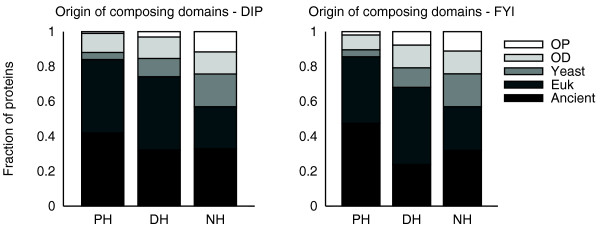
Protein age. The age of a protein is here estimated from the age of its domains. Domains may be found in: eukaryotes and prokaryotes (Ancient); eukaryotes (Euk); or yeast. Domains and proteins that lack homologs are called orphan domains (ODs) and orphan proteins (OPs). The age of a single domain protein is equal to the age of its composing domain, whereas each domain family represented in a multi-domain protein contributes equally to its age classification. Furthermore, each protein contributes equally to the age of its connectivity group. Hence, a two-domain protein may be half ancient and half eukaryotic. The figure shows fractions of proteins, that is, party hubs (PHs), date hubs (DHs) and non-hubs (NHs) in each age class in DIP and FYI.